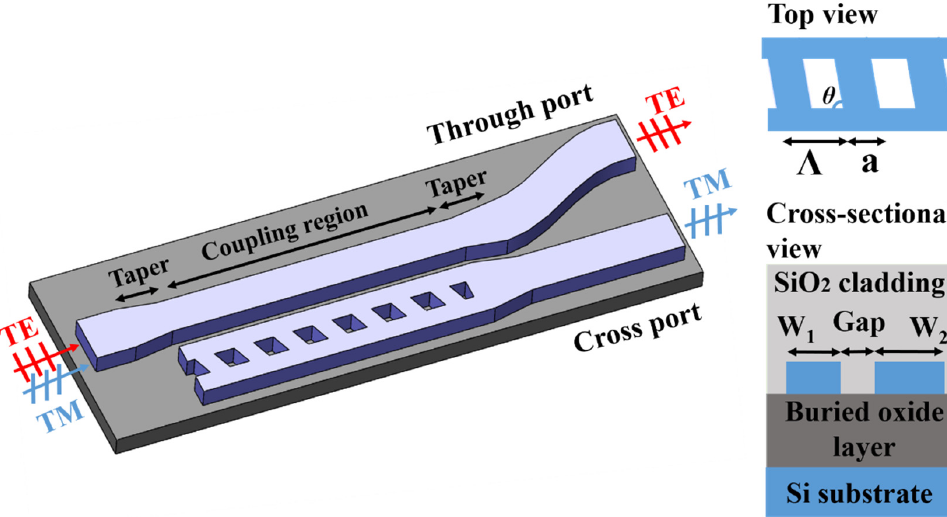
Figure 1. Schematic illustration of the proposed tilted gratings based polarizing beam splitter. The widths of the strip and tilted gratings waveguides are W 1 and W 2 , respectively. The grating period is Λ with ridge width of a and duty cycle of a/ Λ . The refractive indices are 1.444 and 3.476 for SiO 2 and Si, respectively. To suppress the diffraction effects, the grating period should be shorter than λ / 2 n eff , which corresponds to the Bragg condition with λ for working wavelength and n eff for effective mode index. The grating period and duty cycle are chosen to be 400 nm and 0.5 respectively for easy of fabrication. The